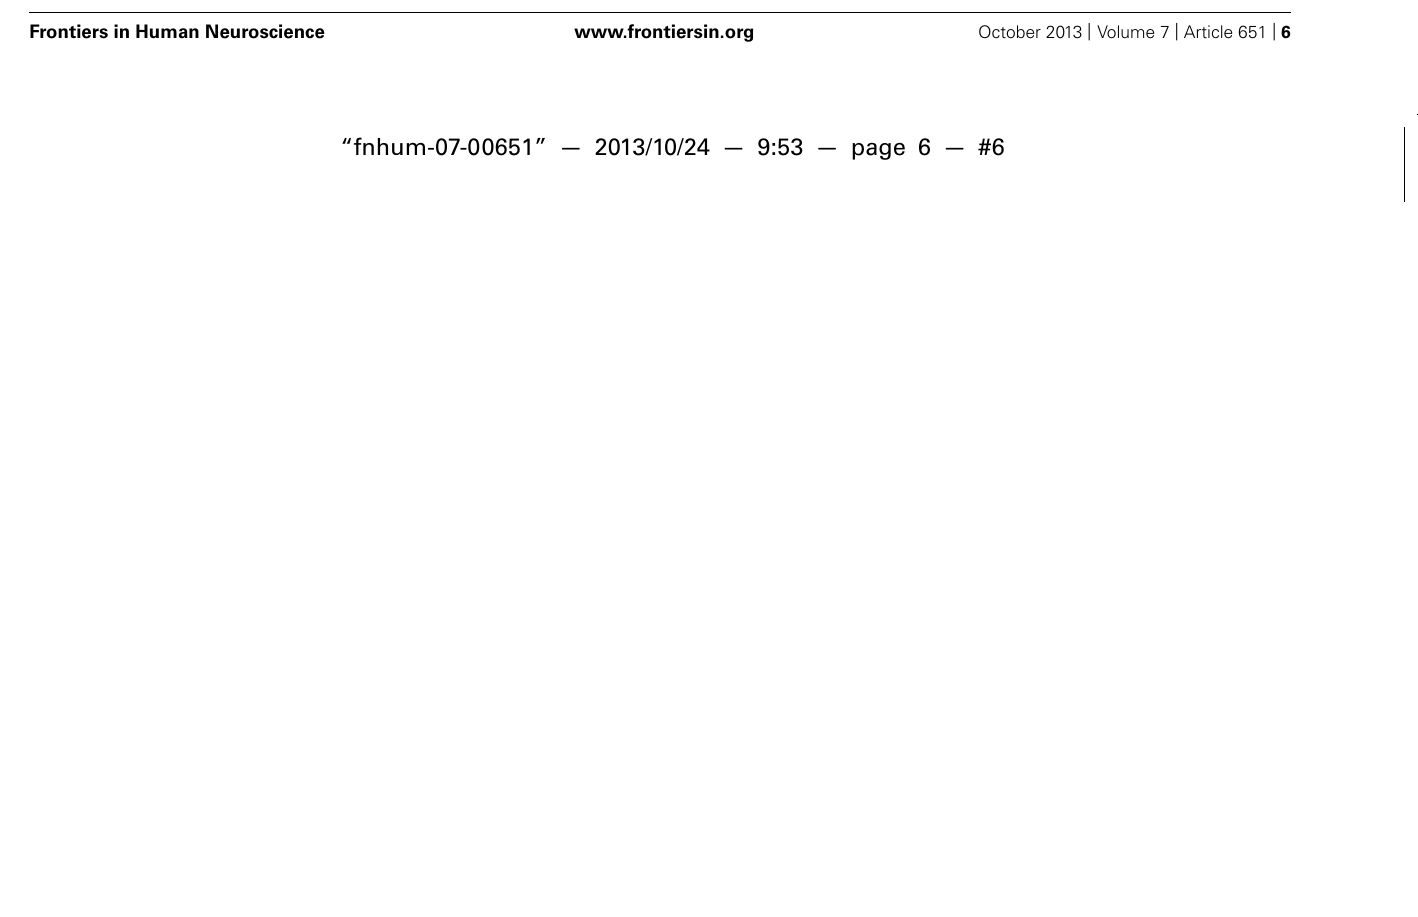
FIGURE 4 | (A) Trial structure of the flanker task in experiment 2. A central fixation dot was presented for 1000 ms, followed by an arrow array for 100 ms. Afterward the central fixation dot was presented again for 900 ms. Responses could be conducted after stimulus onset and before the onset of the first fixation cross (response window = 1000 ms). (B) Schematic